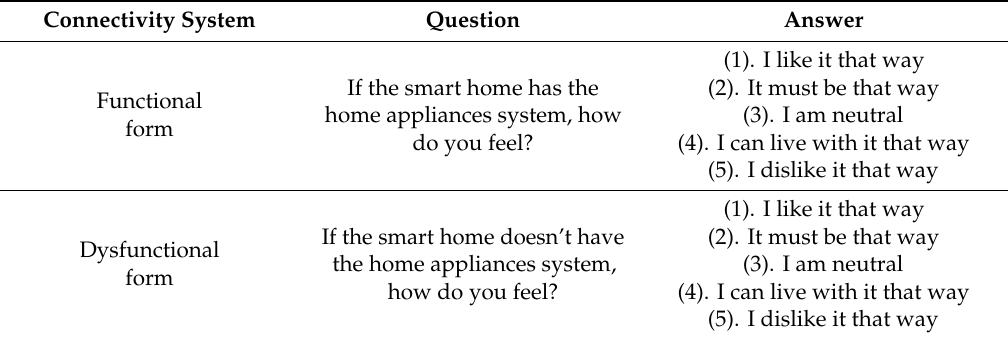
Table 4. Kano model functional and dysfunctional question sample.